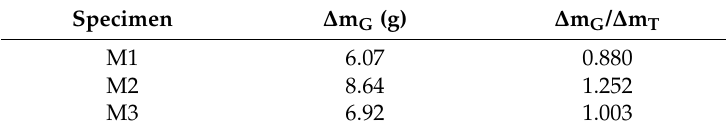
Table 2. Comparison of the gravimetric and theoretical mass losses of the steel bars tested.